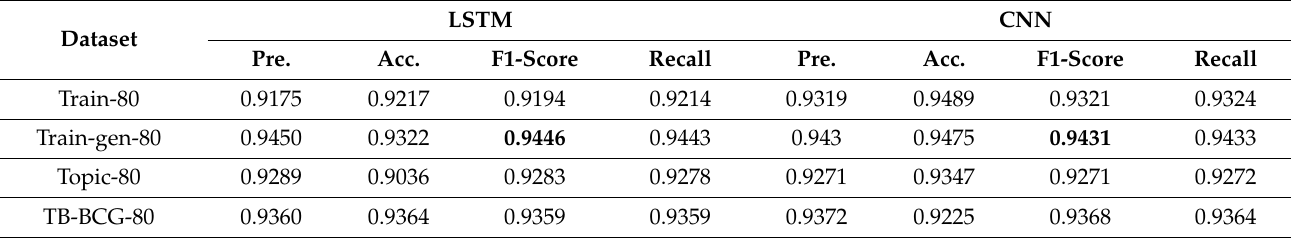
Table 9. Experimental result of 80% dataset.